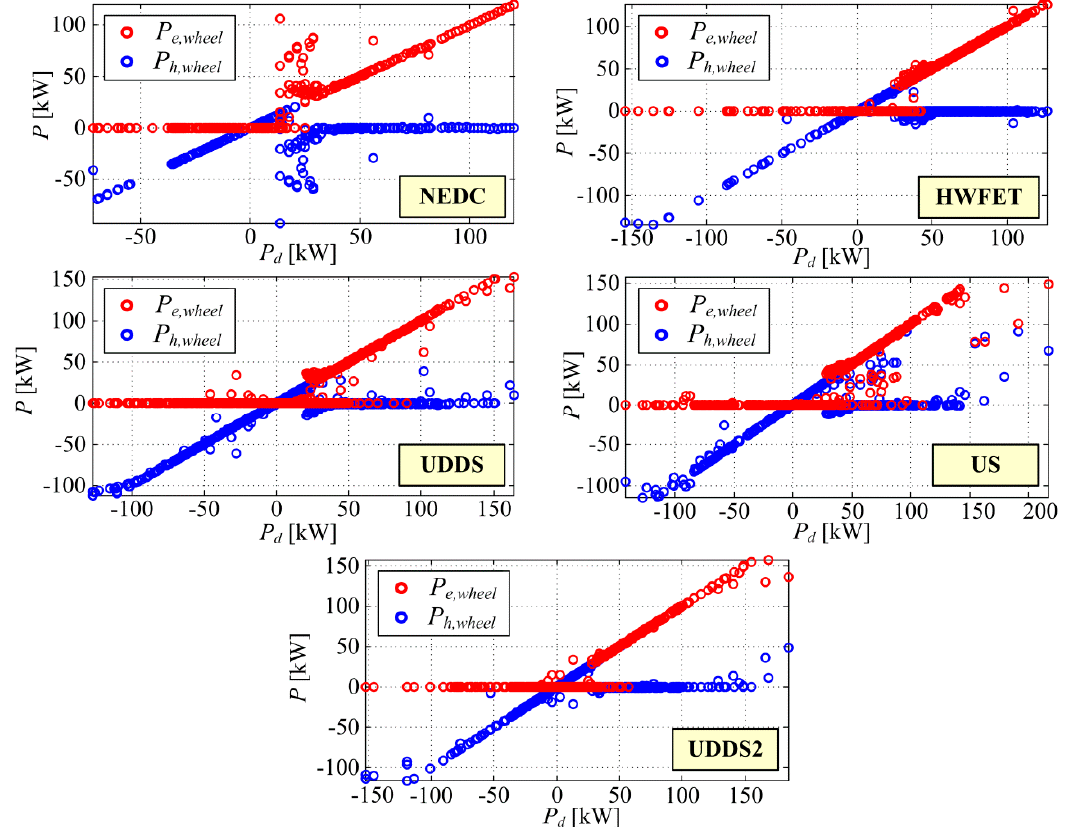
Figure 8. Optimum wheel power from ICE ( P e,wheel ) and hydraulic motor/pump ( P h,wheel )